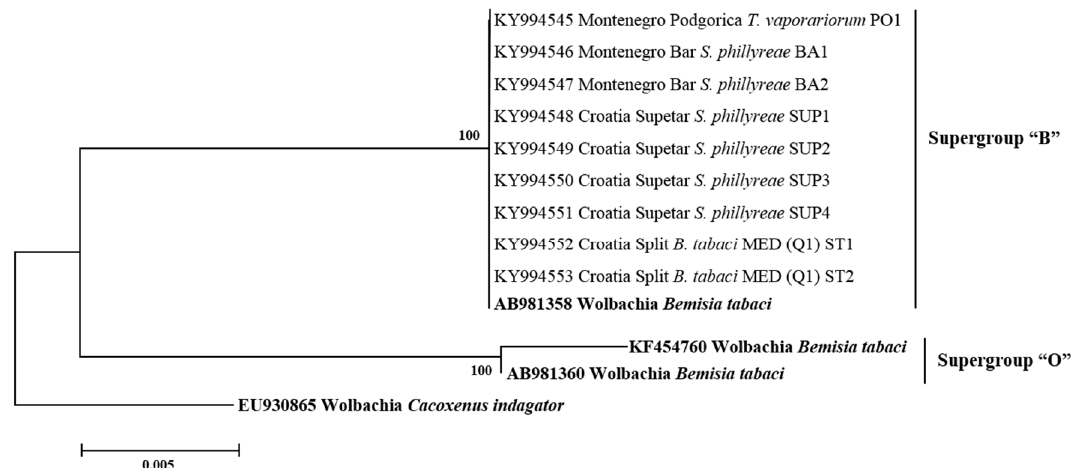
Figure 6. Molecular phylogenetic placements of Wolbachia from whitefly species. The tree was constructed via Bayesian inference (BI) using a GTR+G substitution model. Sequences from GenBank are indicated in bold, while those obtained in this study are rearranged based on geographical origin and associated whitefly hosts, B. tabaci , T. vaporariorum , and S. phillyreae .